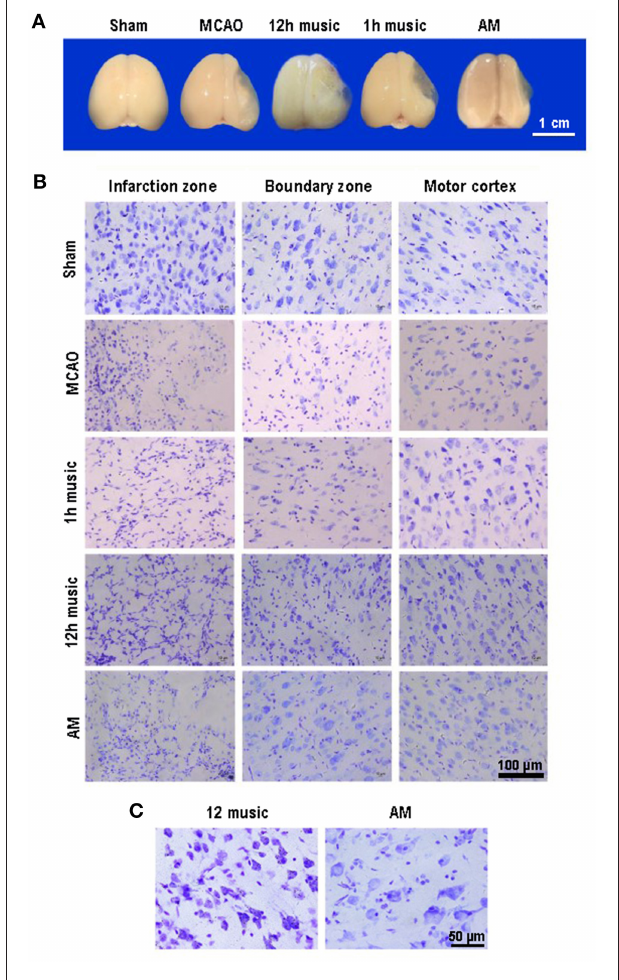
FIGURE 3 | Music therapy induced changes in brain morphology and neuronal repair. (A) Brains of sham, MCAO, 1h music, 12h music, and AM rats 21 days after MCAO operation. (B) Comparison of the effects of forward music and those of 8 × speedup reverse music on neuron repair. Music therapy was started on the eighth day after MCAO, and the treatment continued for 2 weeks. (C) Enlarged morphology comparison between 12h music group and AM